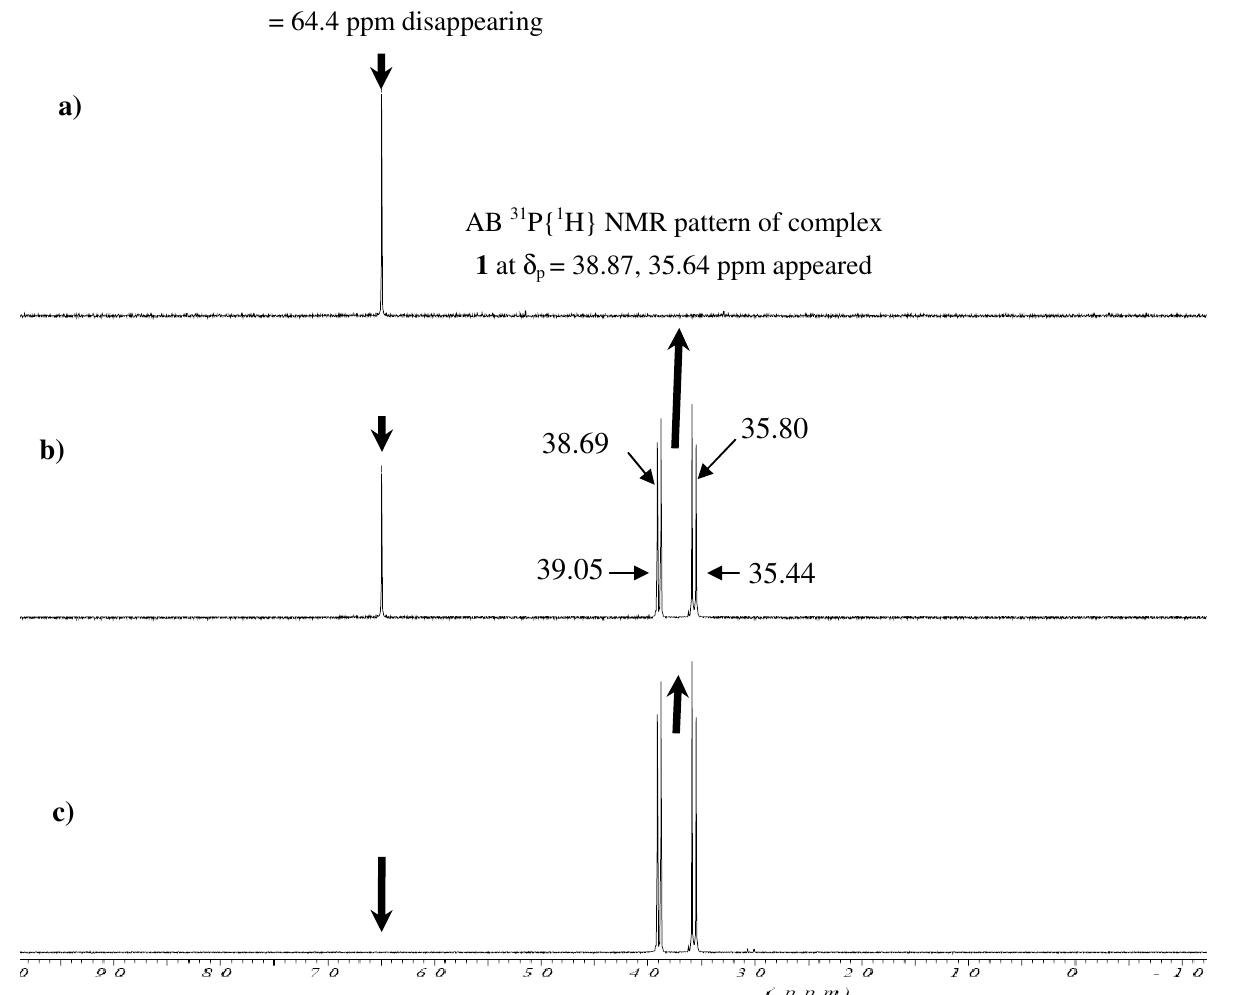
Figure 1. Time-dependent 31 P{ 1 H}-NMR spectroscopic of Cl mixed with equivalent of diamine co-ligand in CDCl 1 at δ = 38.87, 35.64 ppm a) before co-ligand addition, b) the first shot ~ 0.5 min. and c) p the second shot ~1 min. after the co-ligand